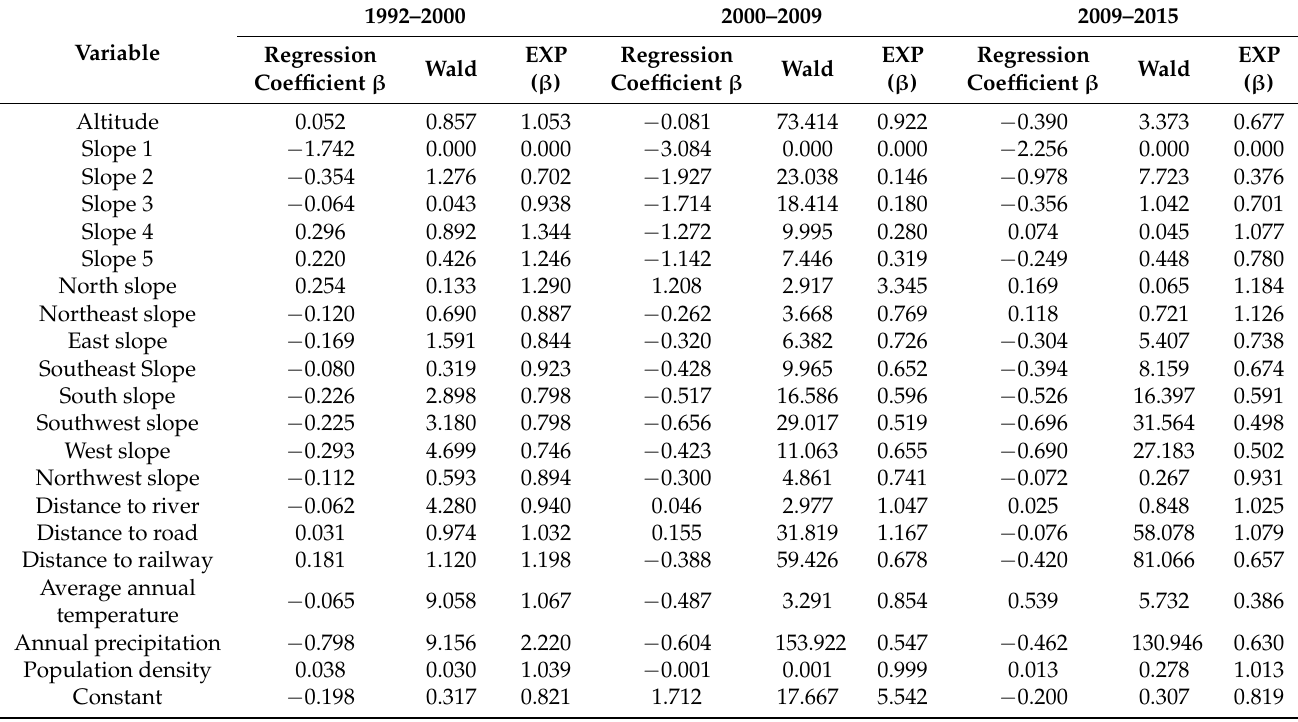
Table A6. Model estimates for Coniferous grassland contraction driving